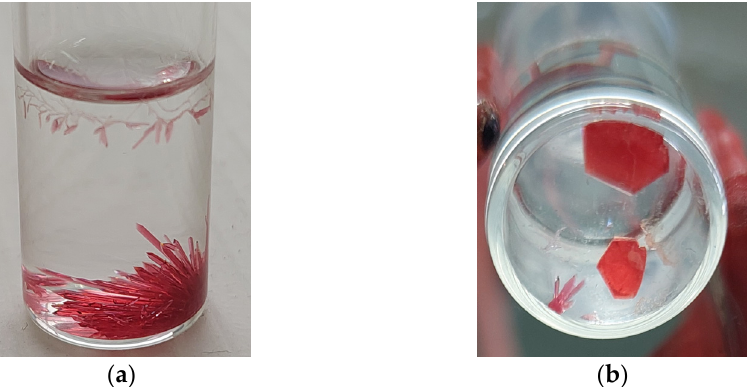
Figure 2. Photos of crystals obtained from the recrystallization of powders of [Ni x Zn (1 − x) (bpy) 3 ](PF 6 ) 2 : ( a ) 10% Ni and 90% Zn (needles); ( b ) 50% Ni and 50% Zn (needles + plates). Vials shown are 13 mm in diameter.